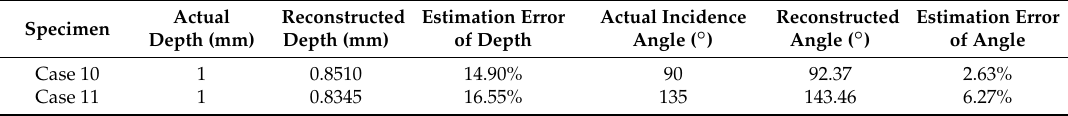
Table 8. The depth and angle evaluations of Case 10 and Case